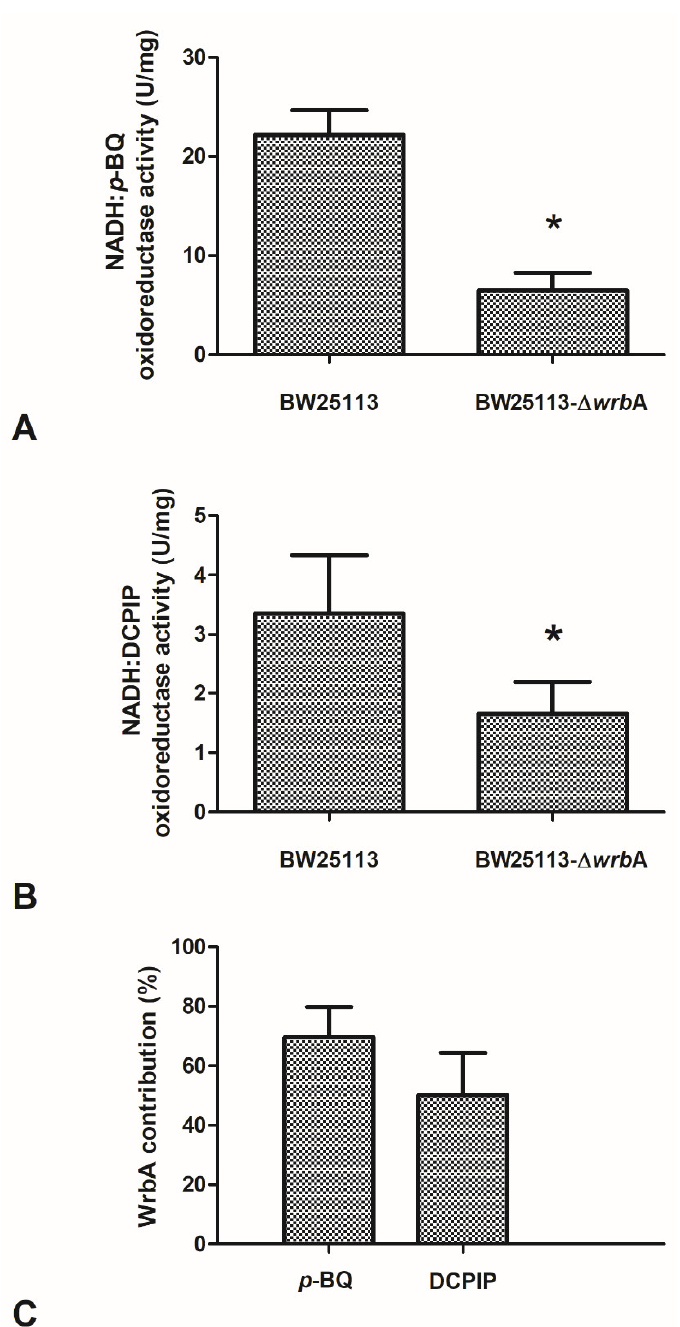
Figure 7. Effects of WrbA deprivation on E. coli NADH-dependent oxidoreductase activity and the contribution of WrbA to this activity. (Panels A , B ) Enzyme reactions were carried out at 25 °C in 50 mM Tris-HCl (pH 7.2) in the presence of 0.2 mM NADH, 0.3 mM p -benzoquinone (panel A ), or 0.1 mM 2,6-dichlorophenolindophenol (DCPIP; panel B ) and a crude extract prepared from cultures of BW25113 or BW25113-∆ wrb A strains. Initial rates of NADH consumption or DCPIP reduction were measured spectrophotometrically at 340 nm or at 610 nm, respectively. (Panel C ) WrbA contribution to the total NADH-dependent oxidoreductase activity of E. coli (BW25113). The enzyme assays were carried out in the presence of 2,6-dichlorophenolindophenol (DCPIP) or p -benzoquinone (p-BQ) as electron acceptors. Data are shown as the means ± standard deviation. The asterisks indicate statistically significant differences (t-test, p ≤ 0.05).